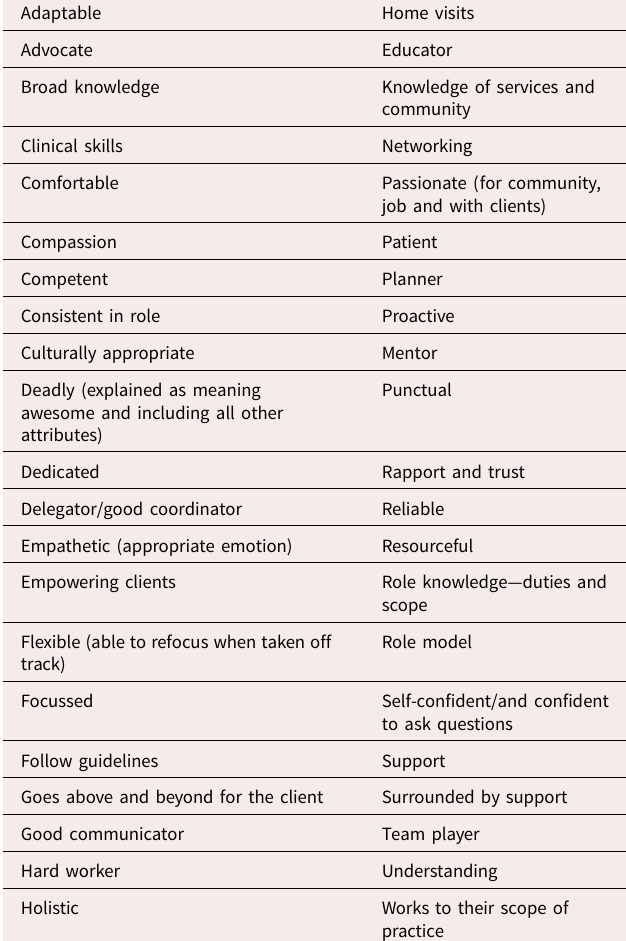
Table 3. Attributes of the best Aboriginal and Torres Strait Islander health worker/practitioner